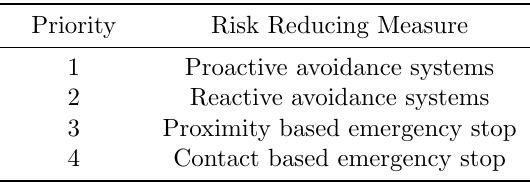
Table 2: Priority for Risk Reducingf Measures Priority